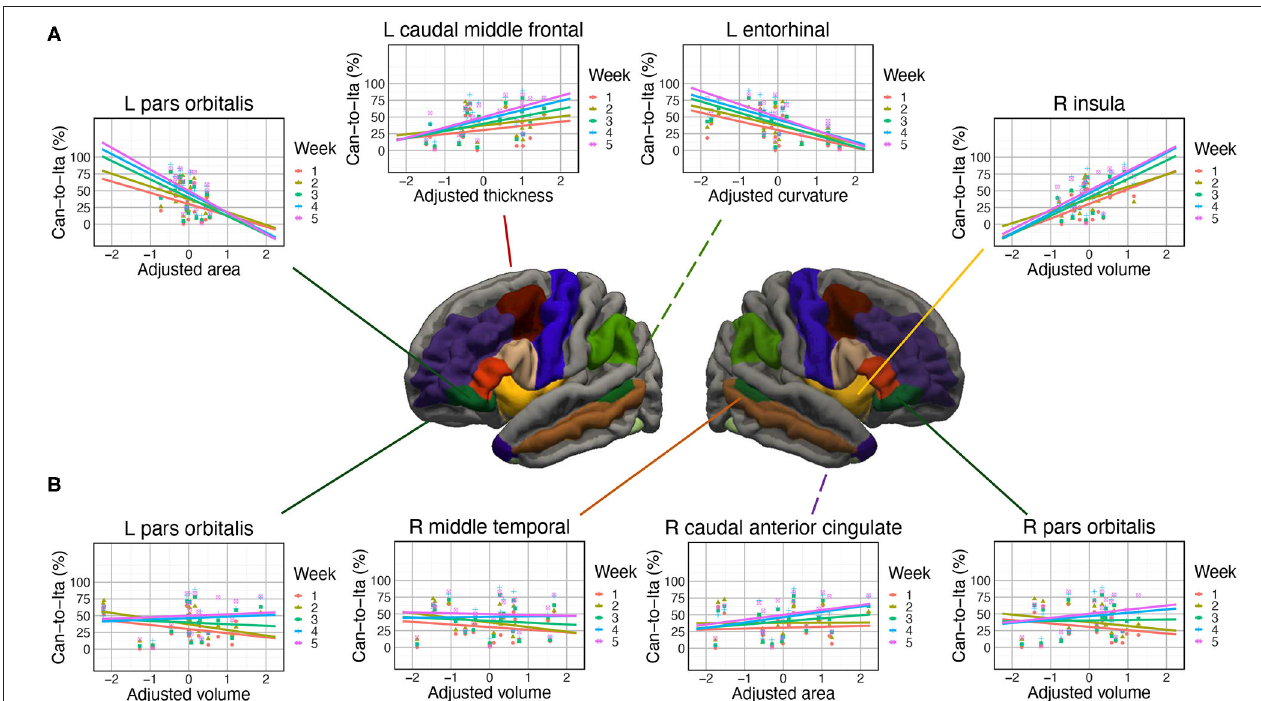
FIGURE 4 | Associations of the in-class Can-to-Ita score with the cortical measures. (A) Significant associations at left pars orbitalis, left caudal middle frontal cortex, left entorhinal cortex, and right insula. (B) Subtle modulations in the degree of association between final test scores with the cortical measures, found at left pars orbitalis, right middle temporal gyrus, right caudal anterior cingulate, and right pars